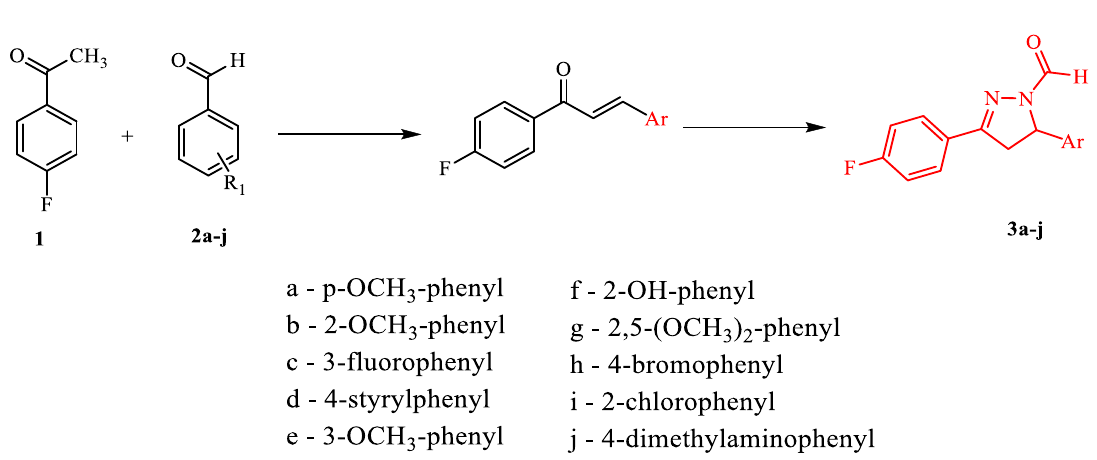
Figure 2. Synthetic pathway for fluorinated pyrazole aldehydes.